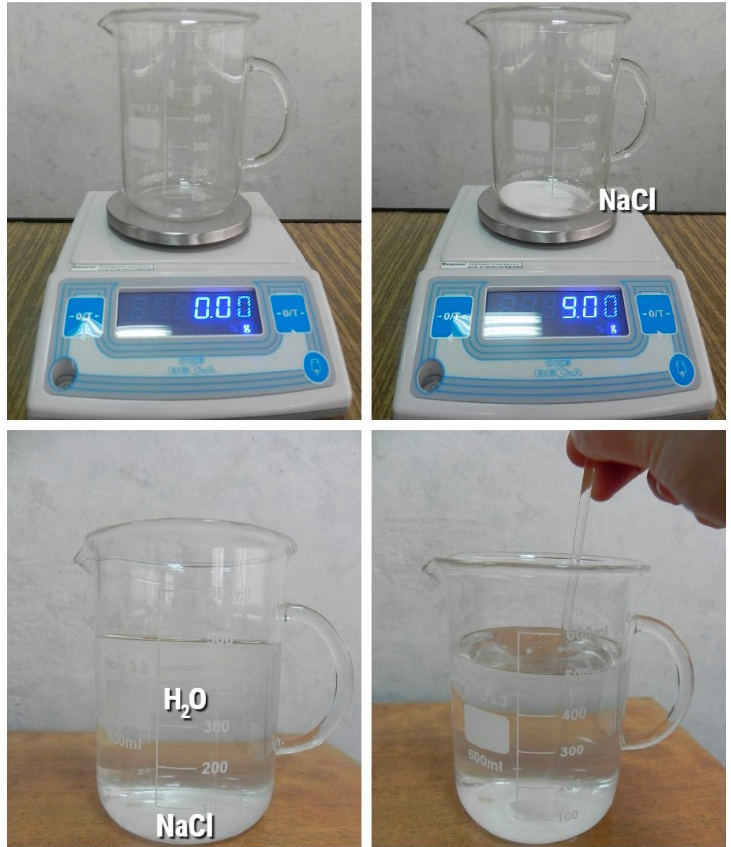
Figure 4. The process of preparing a model seawater solution.